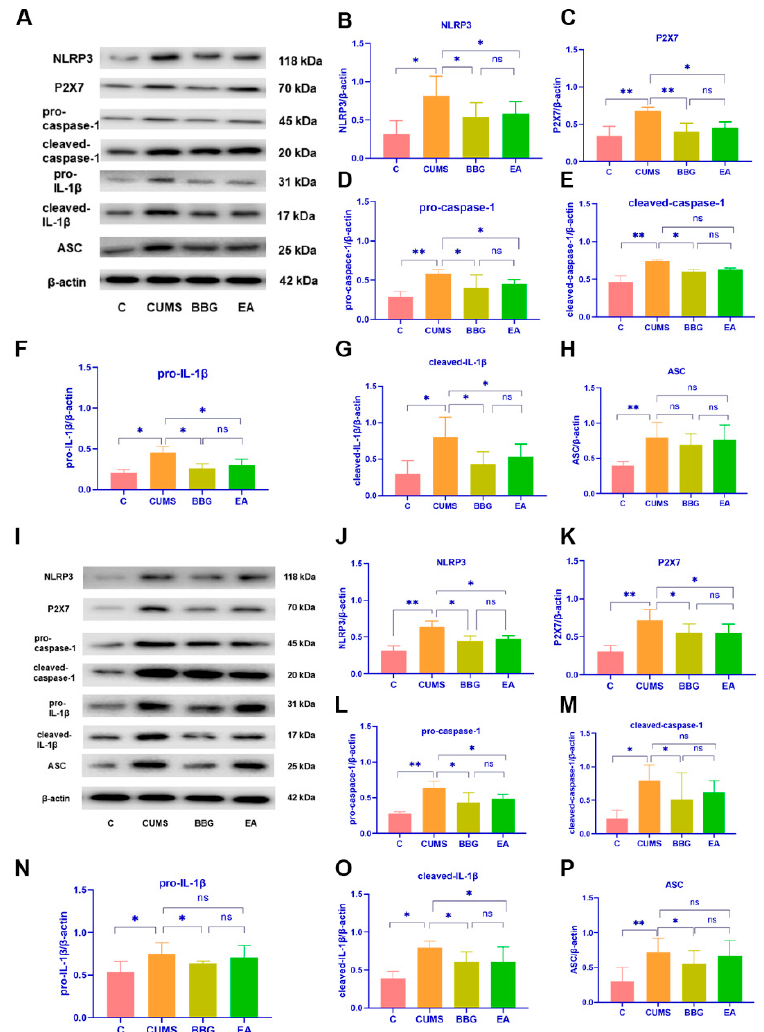
Figure 3. Effects of EA on the expression of the protein of the prefrontal cortex ( A – H ), and the liv- er ( I – P ) of rats of each group. Values are presented as the means ± standard error of the mean. N = 6, * p < 0.05, ** p < 0.01.